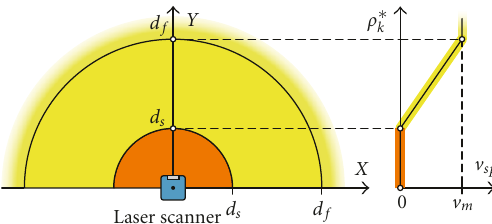
Figure 8: Relation between target distance and speed profile for person following.